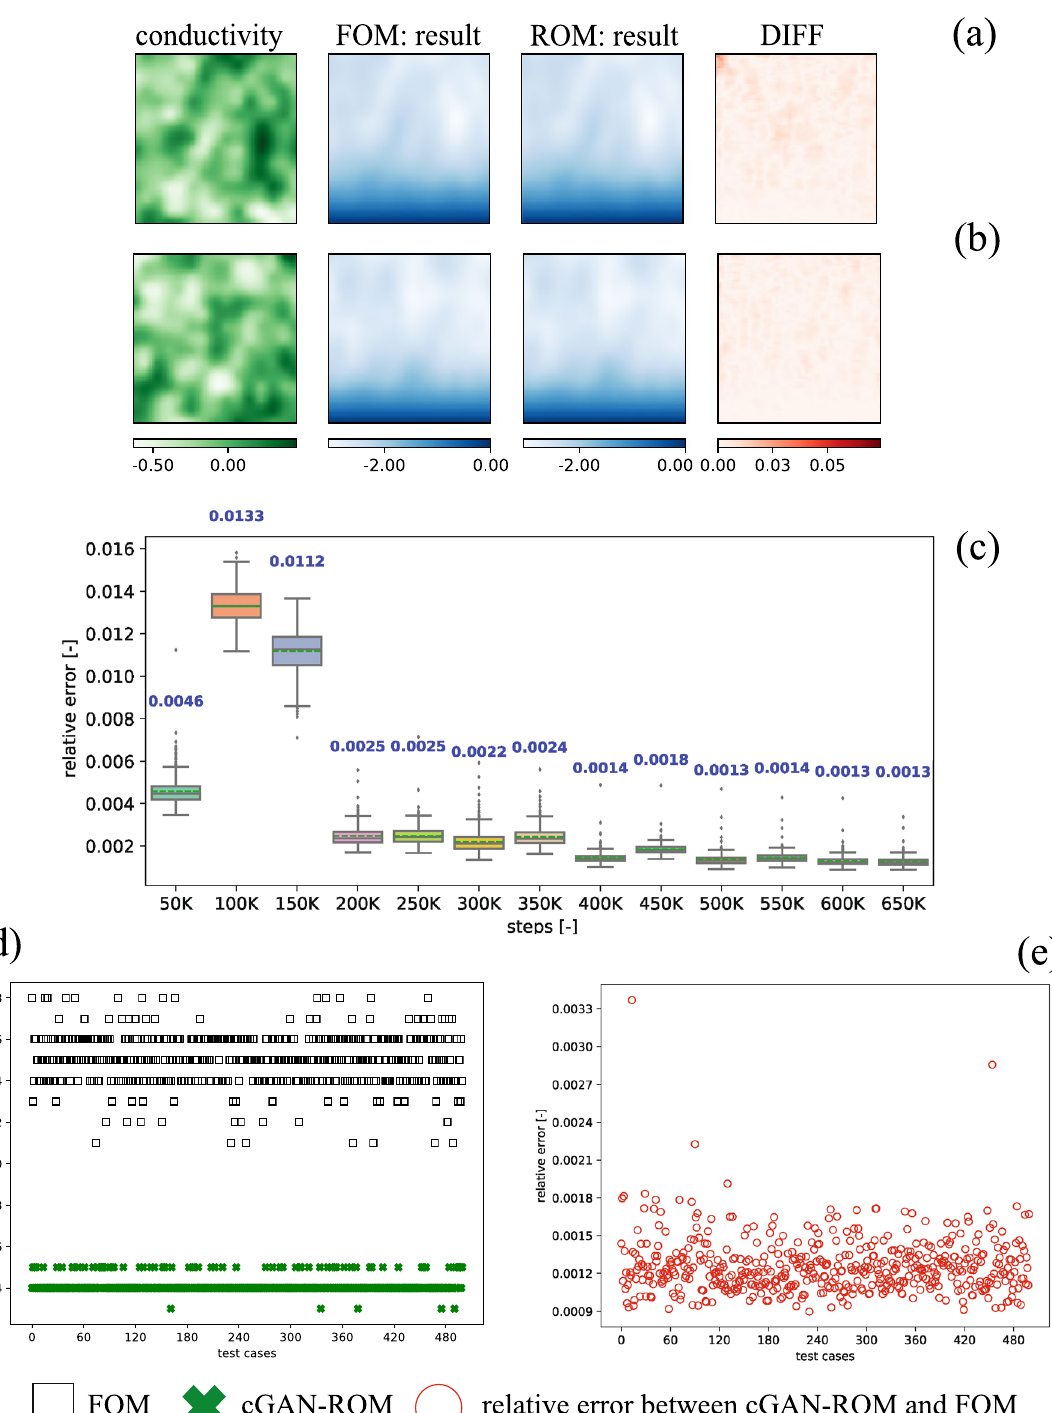
Figure 2. Example 1—results: ( a , b ) are samples of test case results. We have an heterogeneous conductivity as a parameter µ . The FOM and ROM results shown here are pressure head. Both conductivity field and pressure head shown here are dimensionless (see Supplementary sec. 1). ( c ) relative error results of validation set as a function of training steps—we note that each step refers to each time we perform back-propagation, including updating both generator and discriminator’s parameters. The blue text represents a mean value. ( d ) Number of nonlinear iterations: using FOM default initialization, zero-vector initialization, (black square) and using cGAN-ROM-assisted (green cross) and ( e ) relative error of test dataset (red dot). The relative error (see Eq. 3) is calculated between FOM with default initialization (black square) and cGAN-ROM (green